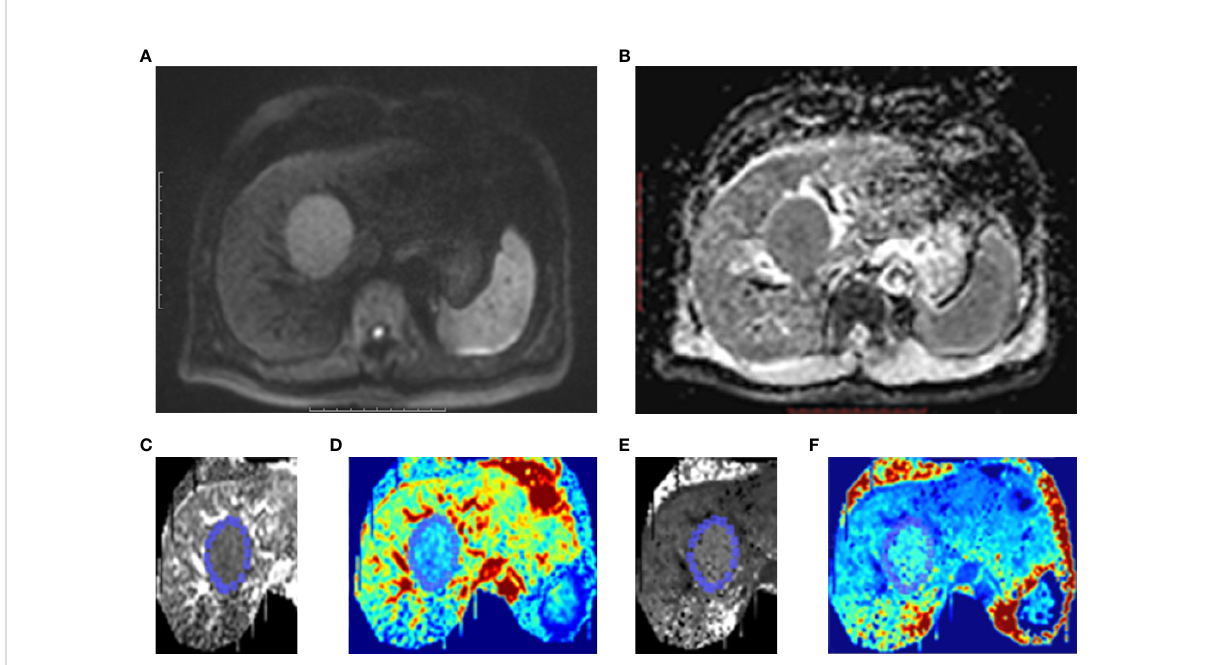
FIGURE 2 One case of HCC patients without MVI. Male, age 39 years, hepatitis B (+). (A) A lesion located at left lobe of liver showed high signal intensity on Diffusion-weighted imaging (DWI). (B) On ADC map, the lesion showed as restricted diffusion. Kurtosis map (C) and corresponding pseudo- color kurtosis images (D) showed lower signal intensity compared with that of liver parenchyma. Diffusion map (E) and corresponding pseudo- color diffusion images (F) showed iso-intensity compared with that of liver